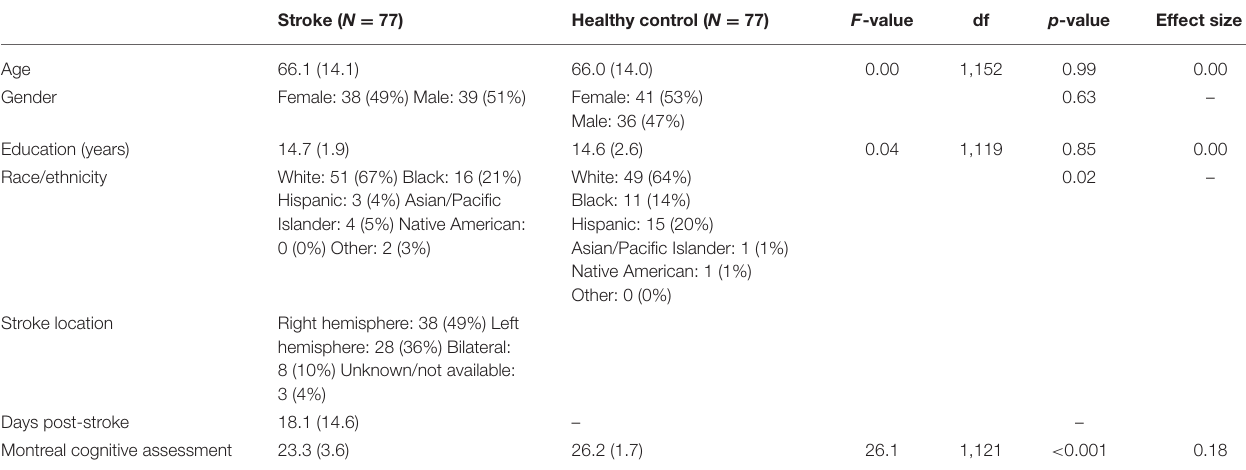
TABLE 1 | Demographic and clinical